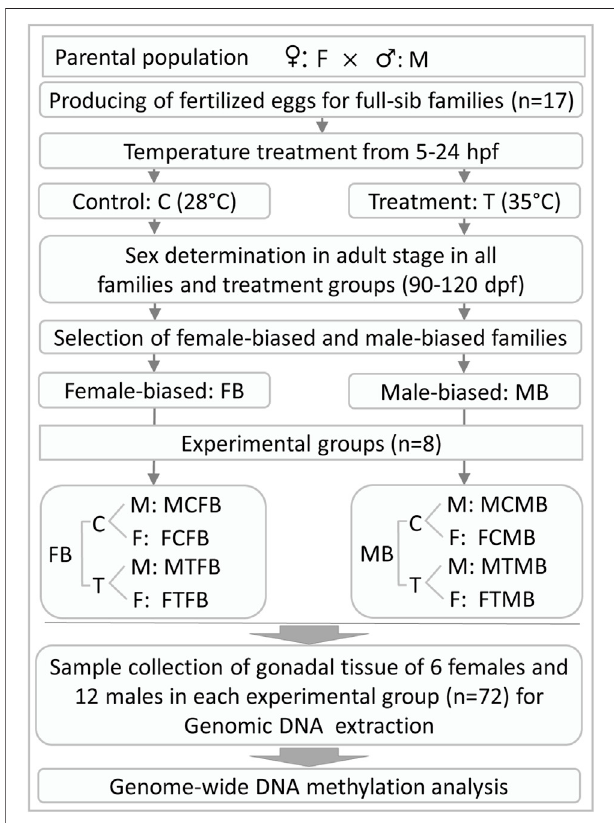
FIGURE1| Generaloverviewofexperimental designandgonadaltissue sample collection for RRBS analysis in this study. hpf, hours post fertilization; dpf, days post